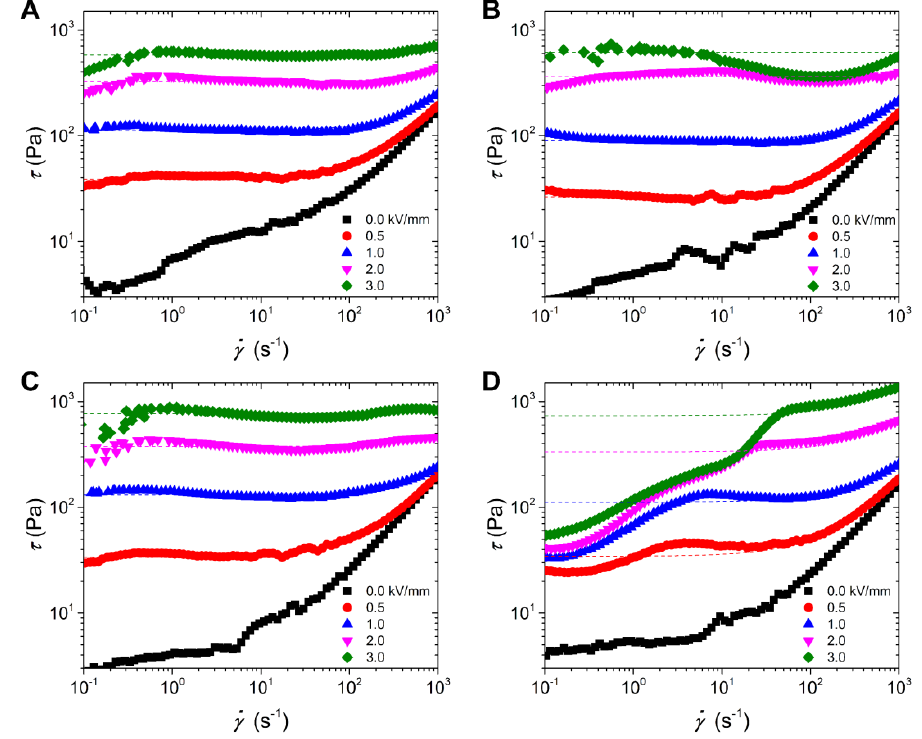
Figure 5. Flow curves of shear stress vs. shear rate for the ER fluids: ( A ) neat PIL, ( B ) PIL/PANI(HCl), ( C ) PIL/PANI(NH 3 ), and ( D ) PIL/PANI(N 2 H 4 ) ( T = 25 °C).